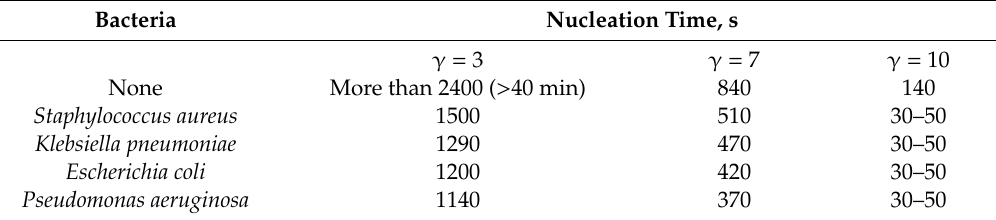
Table 3. Nucleation of calcium oxalates in the presence of bacteria at various supersaturations ( γ ).